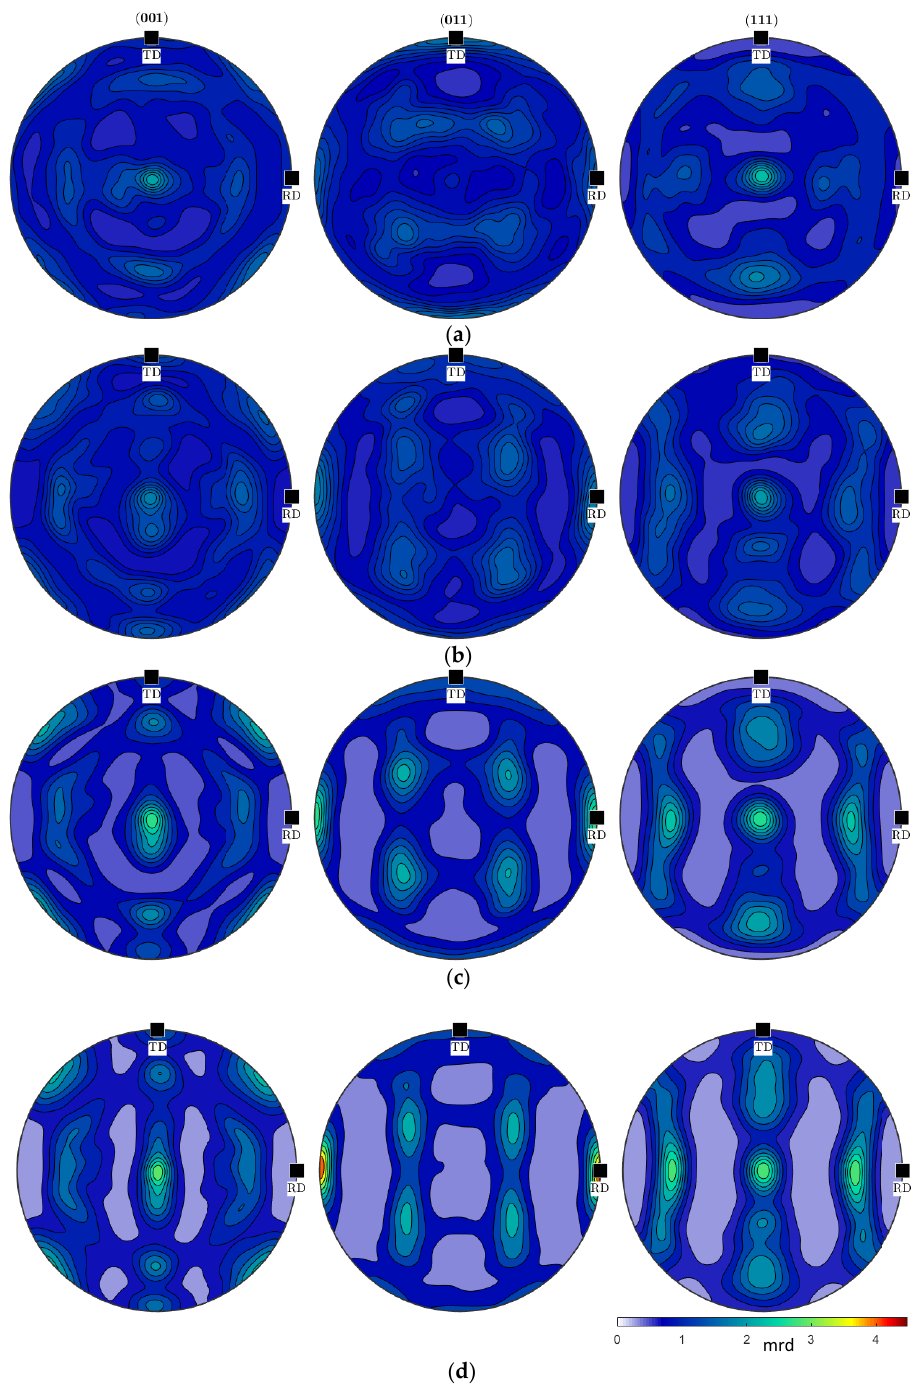
Figure 2. XRD pole figures. ( a ) ε = 2.5%, ( b ) ε = 15%, ( c ) ε = 30%, ( d ) ε = 40%. For small plastic straining of 2.5%, the weak texture γ -fibre was found. Conversely, strengthening of the {111}<123> , {001}<110> rotational cubic, and {110}<001> Goss texture components were found with increasing plastic strain (see also Figure 3). This effect is typical for deformed materials [21]. The typical {111}<112> texture component was shifted by approximately 15° from its ideal location to {111}<123>, for all samples. The strength- ening of the rotational cubic and {111}<123> texture components, which is evident from the pole figures {110} , results in the easy magnetisation axis perpendicular to the RD. ( a ) ( b )